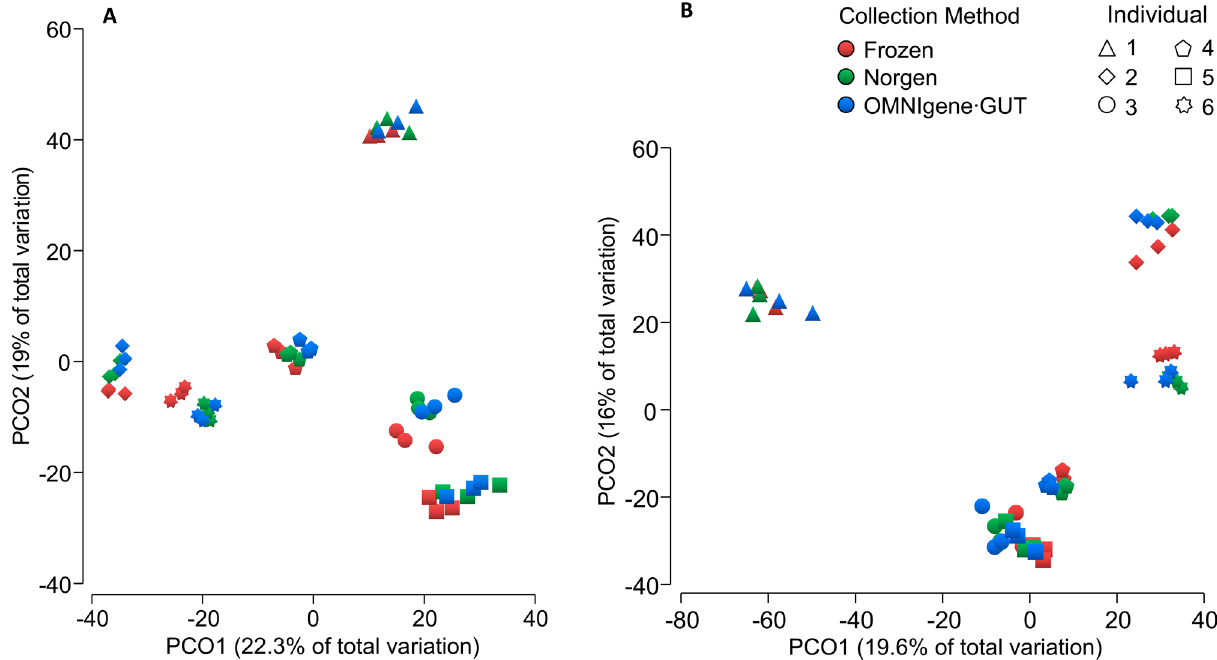
Figure 4. Principal coordinates analysis of β-diversity showing stool samples collected in frozen (n = 18), Norgen (n = 18) and OMNIgene·Gut (n = 18) tube types. Clustering shows directly frozen samples are easily distinguished from stool collected in stabilizing liquid. Data shown in ( A ) was 4th root transformed, using Bray–Curtis similarity distance and ( B ) CLR transformed and Euclidian